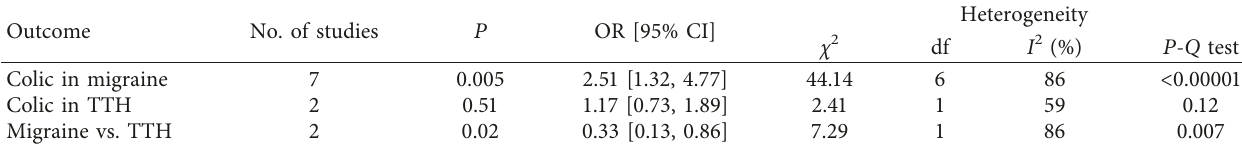
Table 2: Meta-analysis results of the included studies.